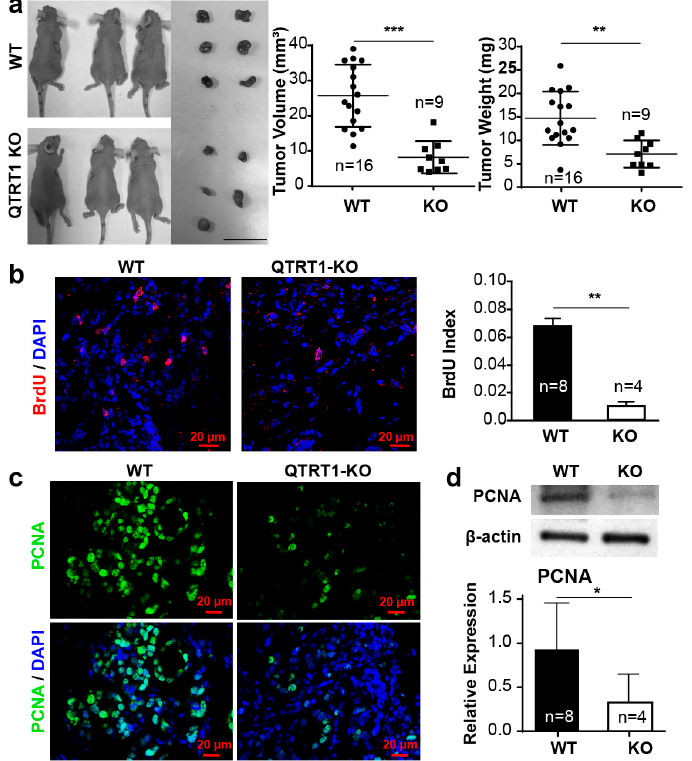
Figure 3. Cont. Figure 3.